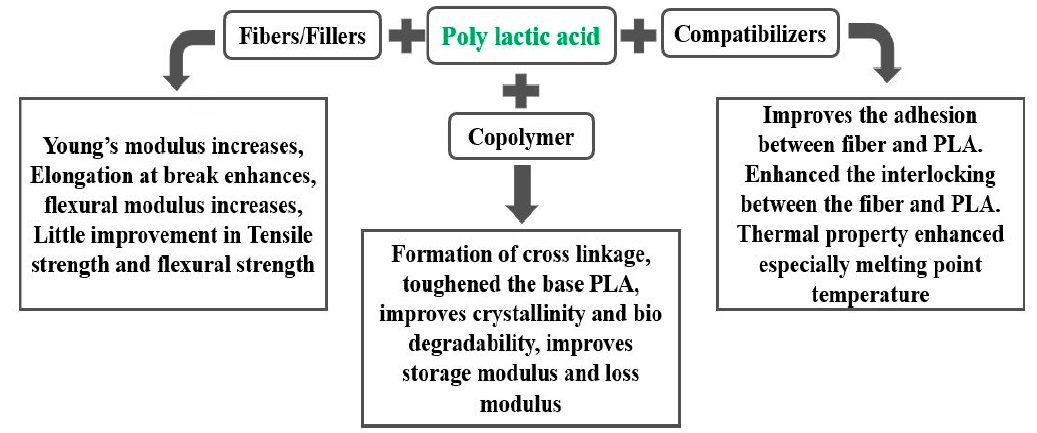
Figure 9. Summarized effect of various reinforcements in